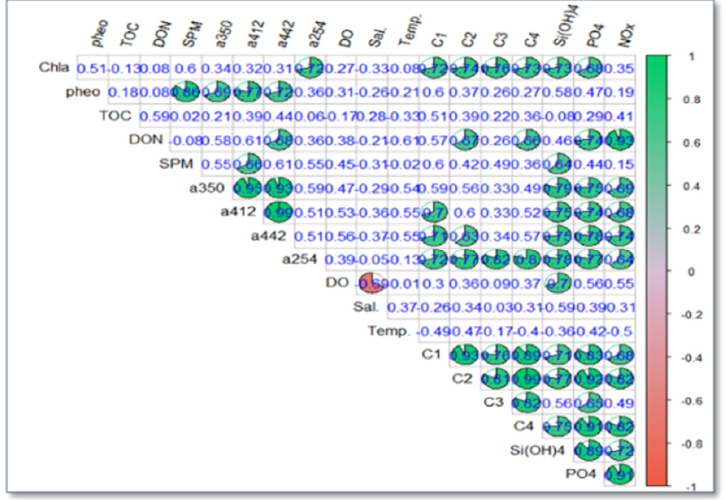
Figure 9. Pearson correlation matrices (method = pie) at the significance level of 0.05 calculated for Table 3. Table